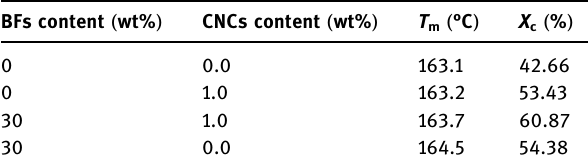
Table 5: DSC results of